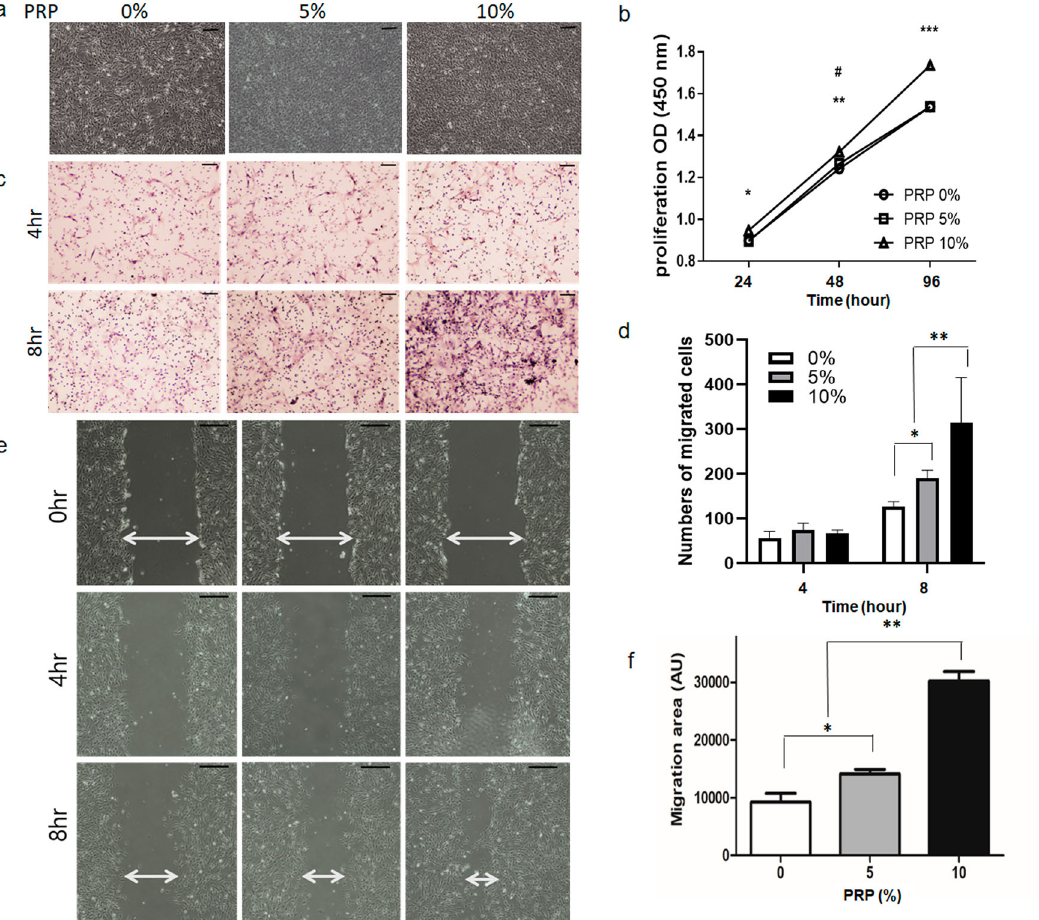
Fig. 4 Analysis of the proliferation and migration of human SCs. a human SCs exhibited a spindle-shaped and bipolar or occasionally multipolar cell morphology. As the concentration of PRP was increased, the proliferation of human SCs increased. (scale bar, 100 μ m). b The number of human SCs were increased signi fi cantly and dose-dependently by PRP. After treatment for 96 hours, 10% PRP increased SC cell count signi fi cantly more than in non-treated controls. (#, compared between 0% and 5%, # P < 0.05; *compared between 0% and 10%, * P < 0.05, ** P < 0.005, ** P < 0.0001). c Representative light photomicrographs of migrated human SCs induced by 0%, 5%, and 10% PRP after incubation for 4 or 8 h by the transwell assay (scale bar, 100 μ m). d Human SCs treated with 5% PRP for 8 h had signi fi cantly